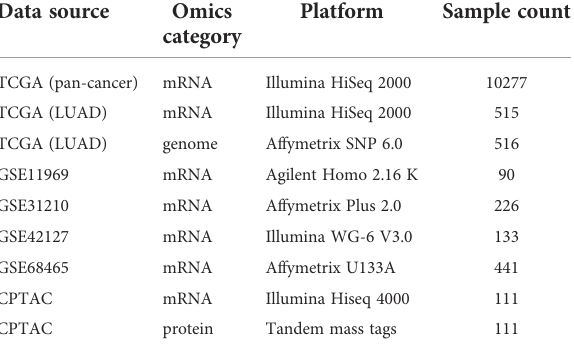
TABLE 1 The datasets used in this